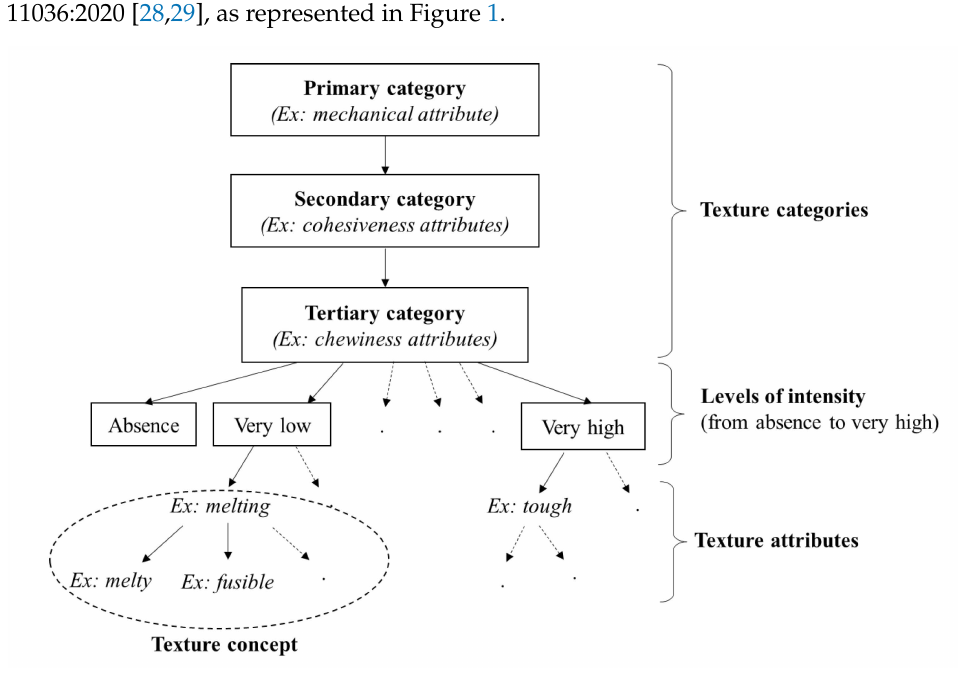
Figure 1. Organization of texture categories inspired by ISO 5492:2008